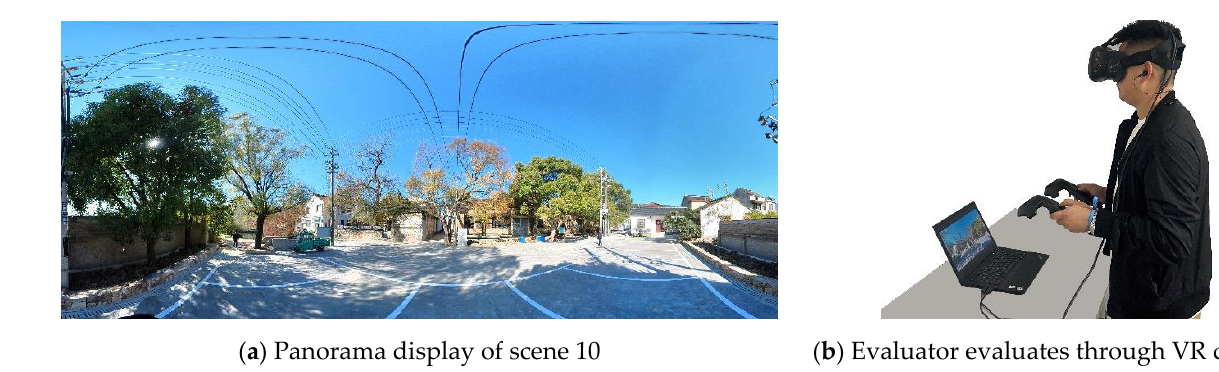
Figure 4. Scenic beauty